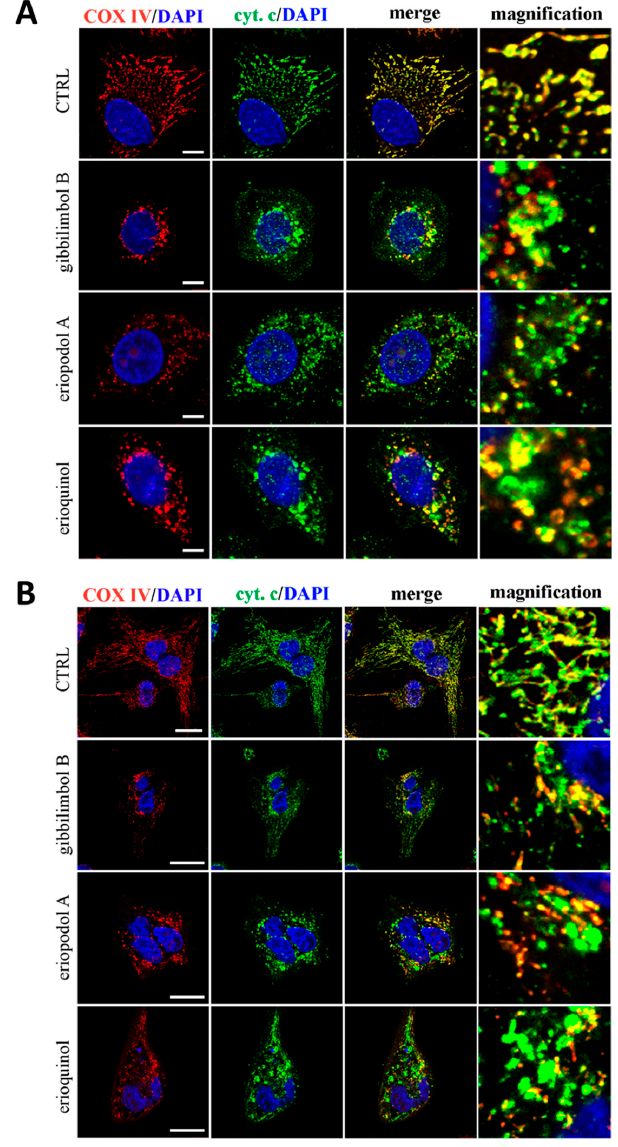
Figure 8. Confocal microscopy for co-localisation of cytochrome c with mitochondria. ( A ) MCF7 and ( B ) U373 cells were treated for 3 h in the absence (CTRL, control) and in the presence of gibbilimbol B/eriopodol A (30 μ g/mL) or erioquinol (10 μ g/mL). Cells were then stained for cytochrome c (green)